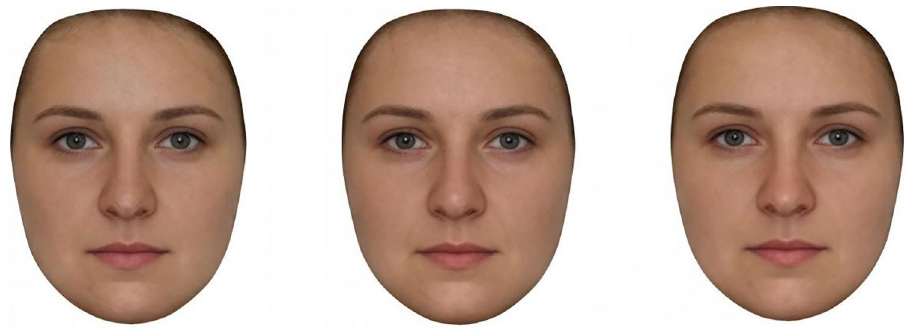
Figure 1. Example of visual stimuli presented to participants in the 3AFC block examining the perceived attractiveness of the “textbook” group. Left: early follicular phase, middle: peri-ovulatory phase, right: mid-luteal